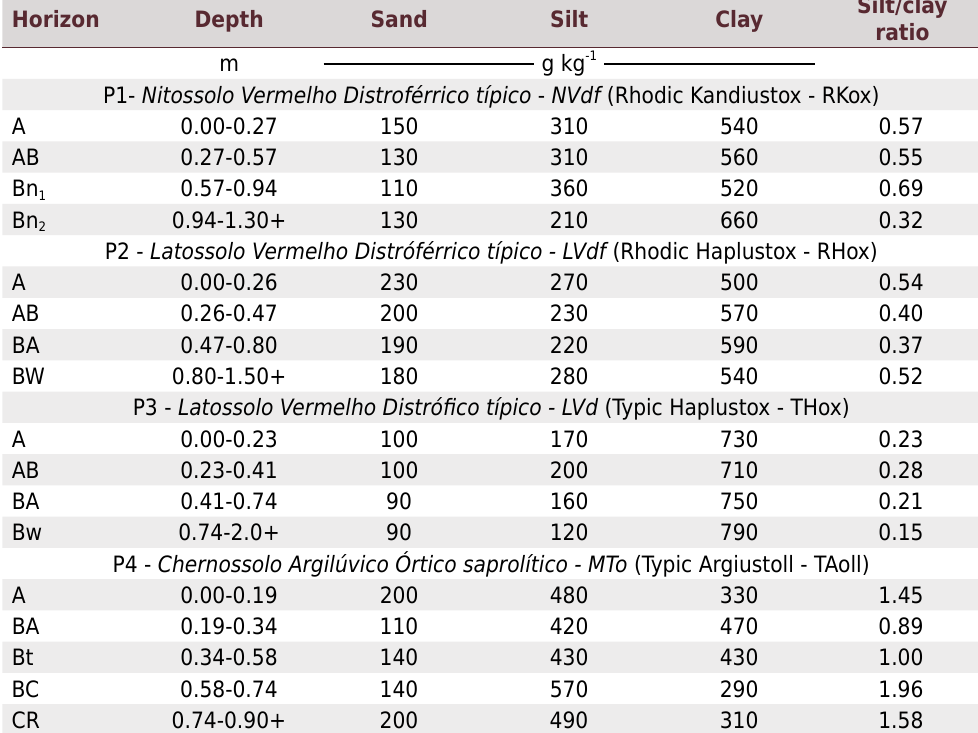
Table 1. Particle fraction distribution in soils of the Southern Espinhaço Mountain Chain and Upper Jequitinhonha Valley Horizon